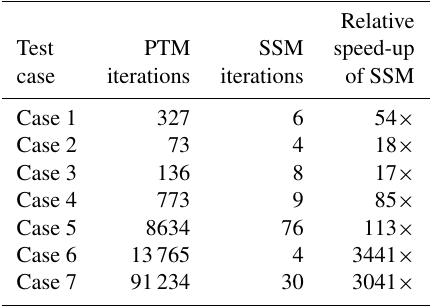
Table 2. Newton iterations required to achieve convergence for benchmark geometry test cases. The converged results are identi- cal for both methods.